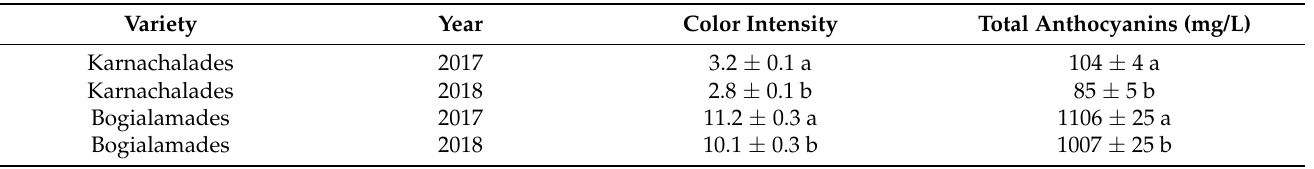
Table 6. Results from One–Way Analysis of Variance (ANOVA) with Tukey’s test, of color characteristics of “Karnachalades” and “Bogialamades” wines in two consecutive vintages. Mean ± St.